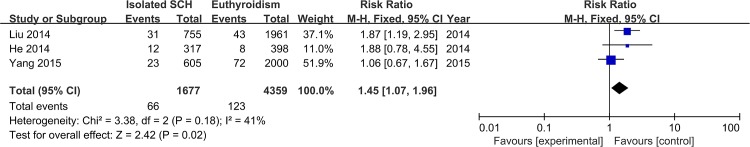
Forest plots for the prevalence of miscarriage risk in isolated SCH patients compared with controls.